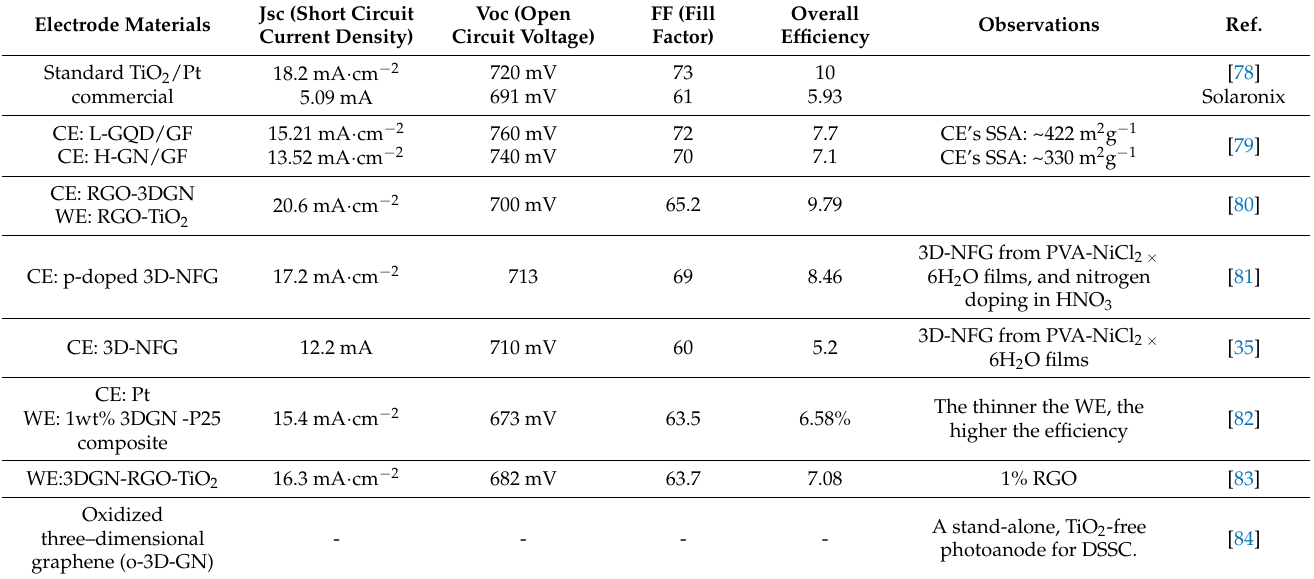
Table 5. Performance of the 3D graphene-based